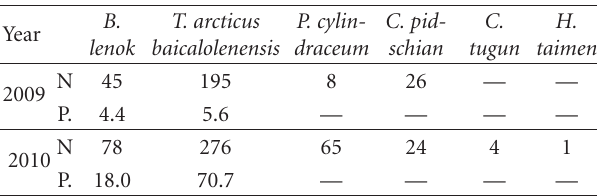
Table 1: Infection of Chechuj River fishes with parasitic worms of the genus Acanthobdella